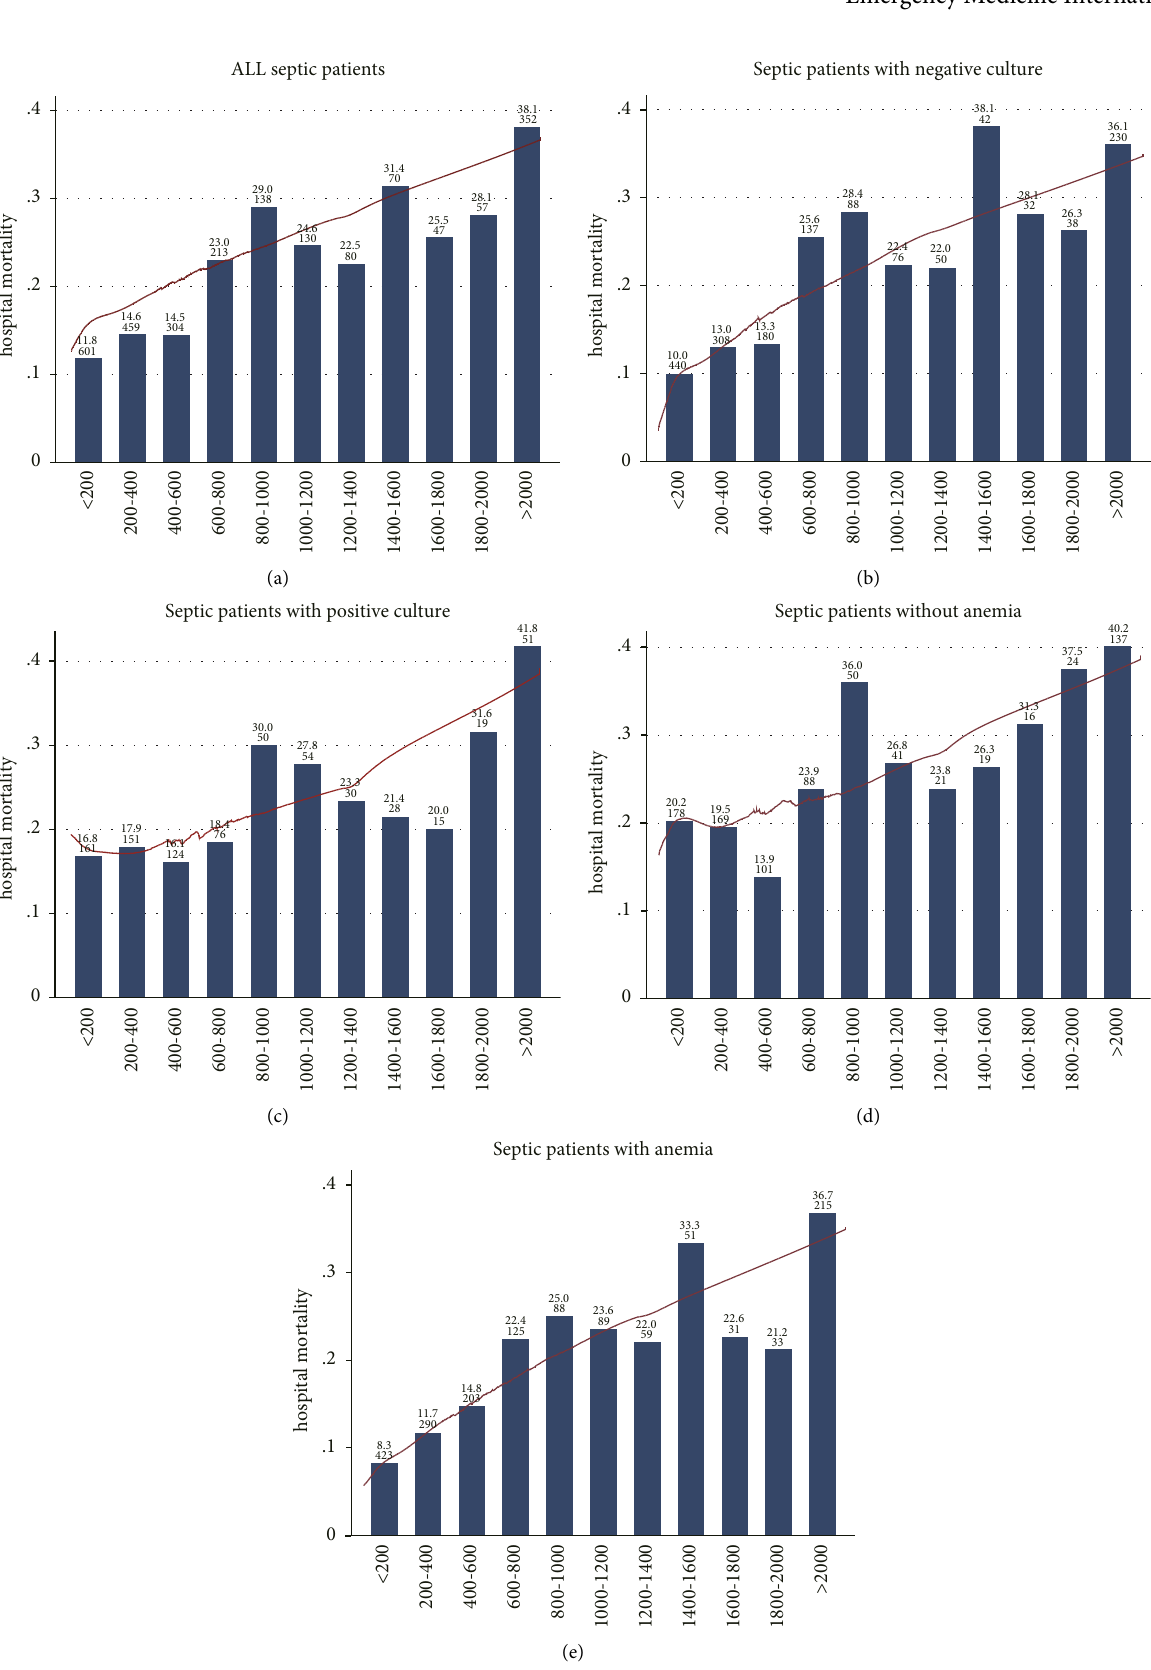
Figure 2: Association between initial serum ferritin and the in-hospital mortality of septic patients. (a) Represents the result obtained from the entire cohort. (b-e) Show the result in those with or without positive culture and anemia. A nearly positive linear relationship was found in those fgures, especially in the entire cohort (a), the negative culture cohort (b), and the nonanemic cohort (e). Te legends on the top of the bar mean the in-hospital mortality (%) and the number of patients